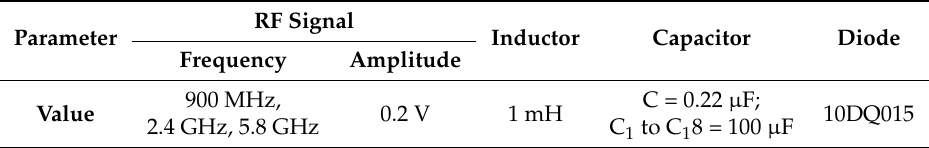
Table 2. The information of RF harvesting energy